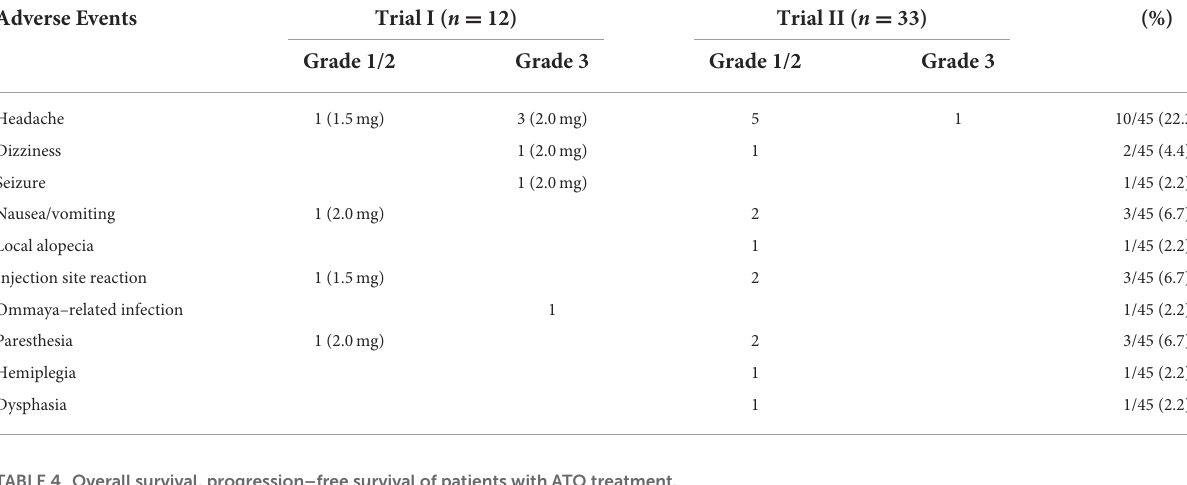
TABLE 4 Overall survival, progression–free survival of patients with ATO